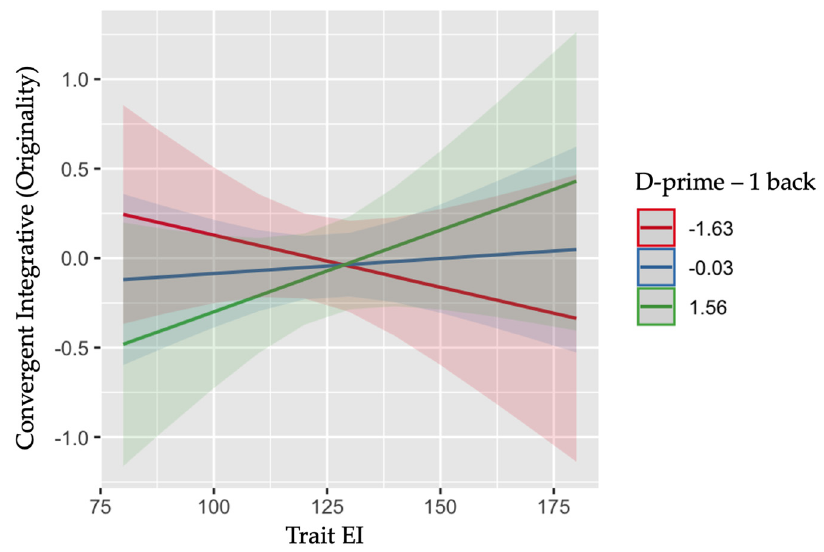
Figure 2. Interactive effect between trait emotional intelligence and n-back (1-back) performance in predicting children’s convergent integrative ability (originality). Larger D-prime values correspond to a higher working memory ability.